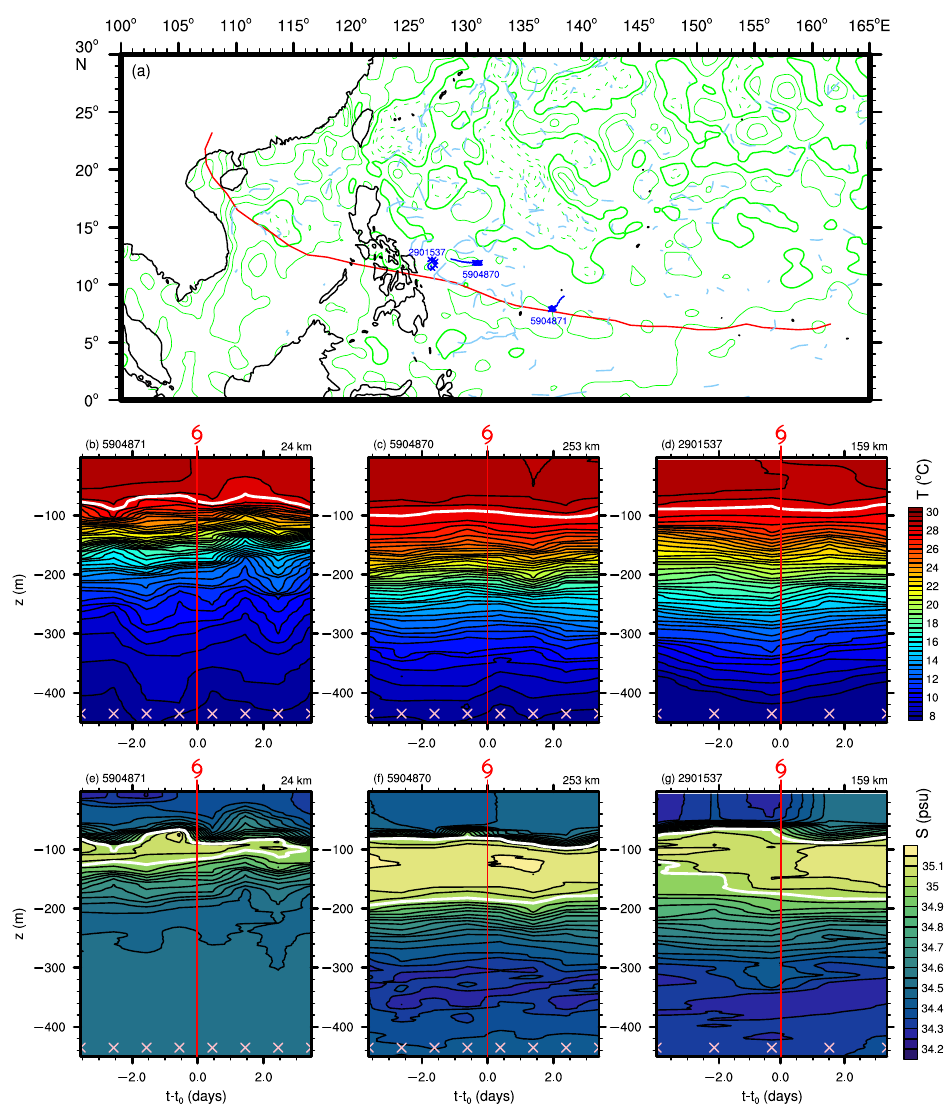
Figure 9. Argo floats affected by super-typhoon Haiyan. ( a ) Trajectories of all Argo float in November 2013 (light blue lines), and the three selected Argo floats for detailed analysis (blue lines). The blue crosses denote the records within 4 days before and after typhoon arrival time. The red solid line is the best-track of Haiyan (JTWC). ( b – d ) Profiling observations of temperature from Argo ID 5904871, 5904870 and 2901537, respectively. The x coordinates are the relative time referred to the arrival time of typhoon ( t 0 ), the pink crosses represent the Argo sampling time. The minimum distances between Argo and typhoon are given at the top-right of subfigures. The isothermal line of 28 ◦ C is highlighted as thick white line. ( e – g ) as in ( b – d ) but for salinity. The isohaline of 35.0 psu is highlighted as thick white